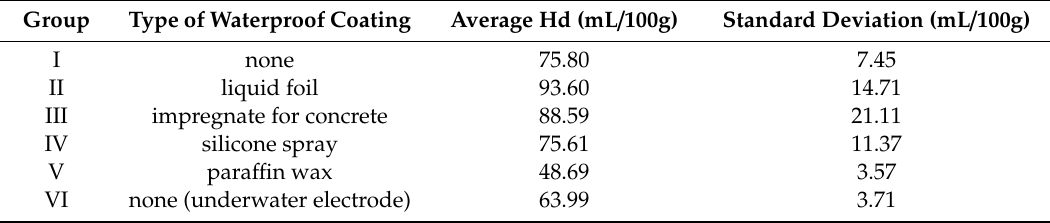
Table 5. The average values of di ff usible hydrogen content